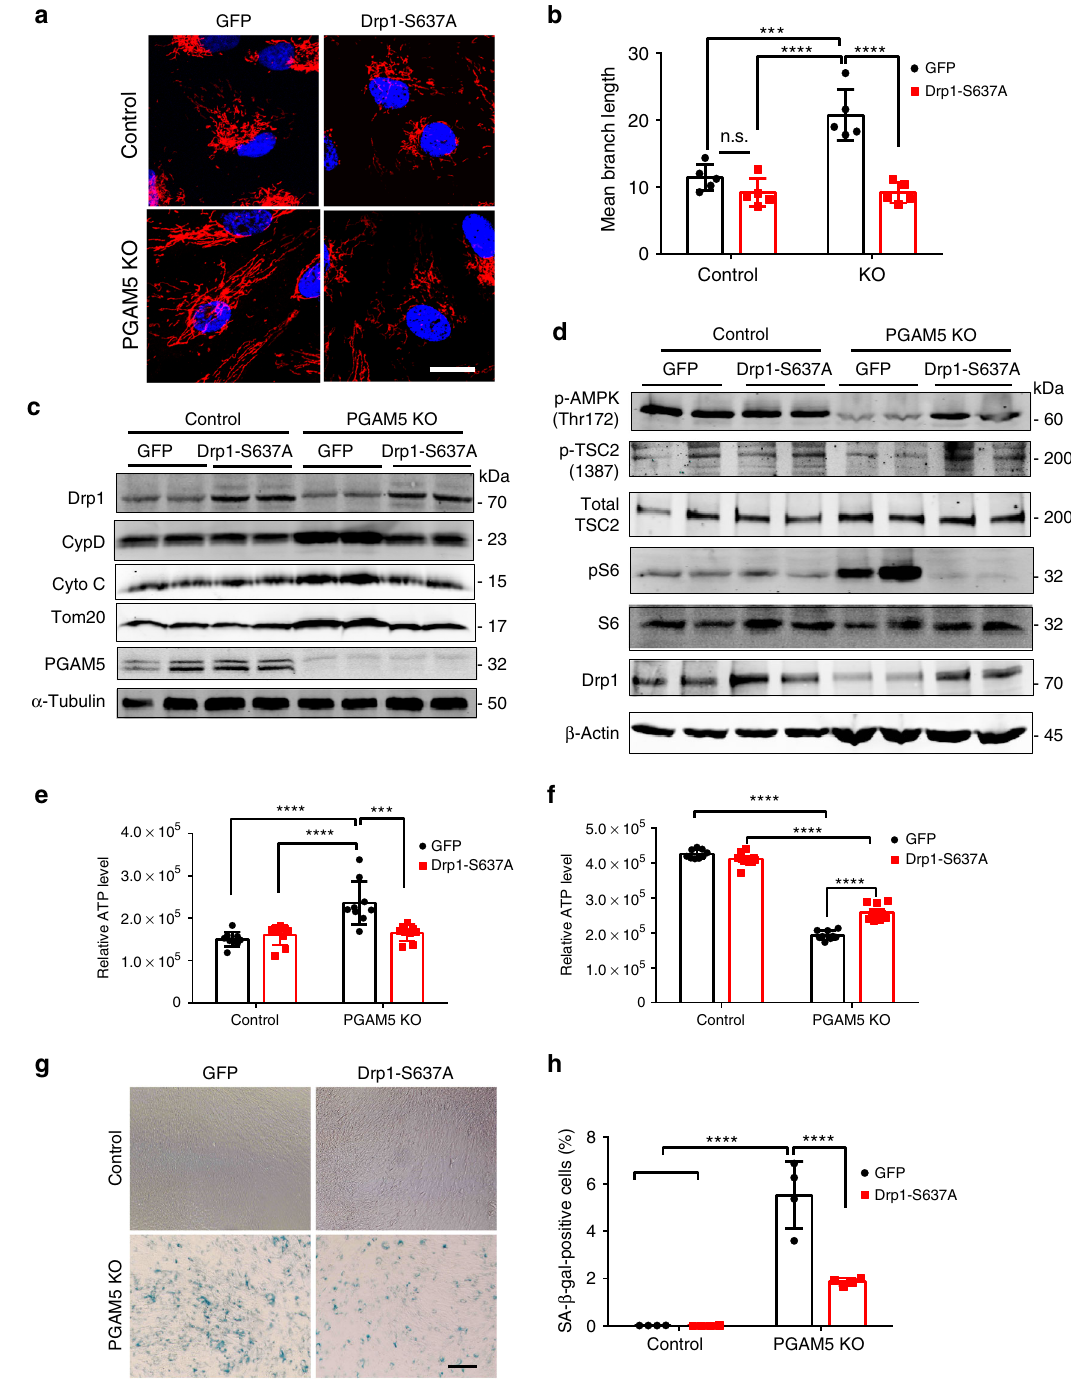
corresponding regions in the WT as shown by ZO-1 (Fig. 7d, right panel) and histology staining (Fig. 7e, KO middle and periphery panels). However, when similar experiments were performed in the 18-months-old mice, RPE protection rendered by Pgam5 deletion was lost (Fig. 7f – j). To con fi rm the results in vitro, neutral red assay and propidium iodide (PI) staining were used to measure RPE cell viability after NaIO 3 treatment. PGAM5 − / − ARPE-19 cells showed signi fi cantly better viability than controls at 12 h after NaIO3 treatment at several concentrations (Fig. 8a). PI staining con fi rmed less cell death in PGAM5 − / − cells compared